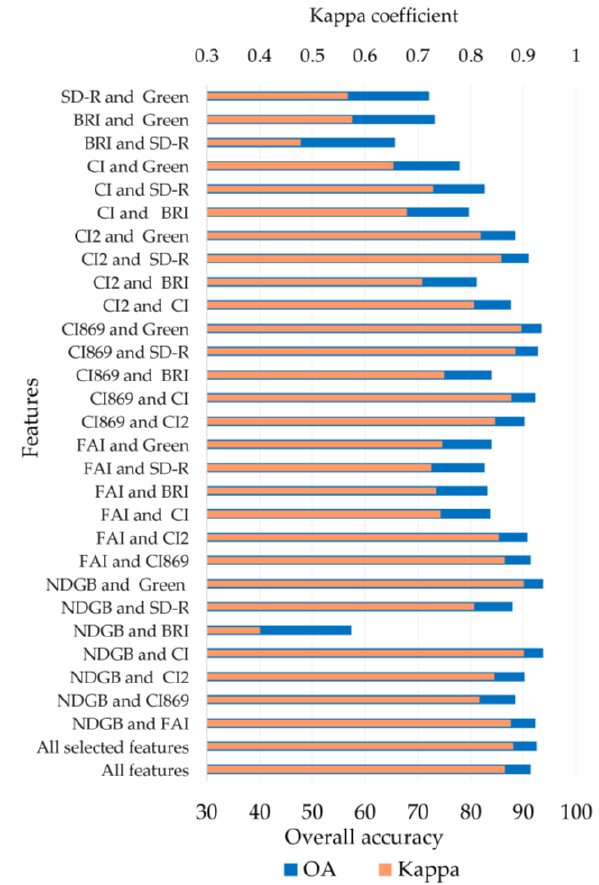
Figure 6. Performance of the combinations of multiple selected features. Remote Sens. 2019 , 11 , x FOR PEER REVIEW